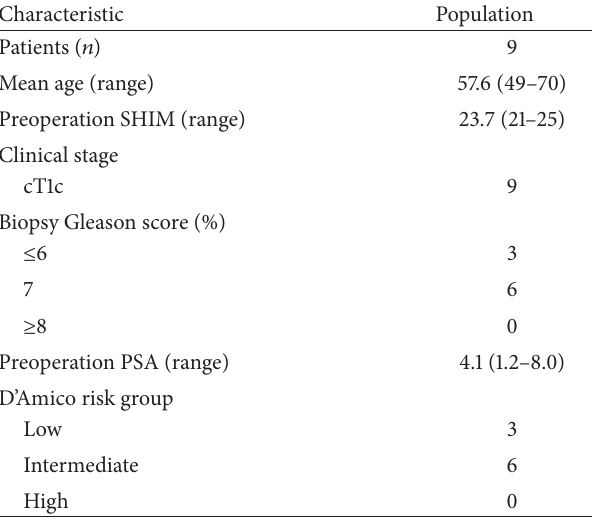
Table 1: Baseline demographic and clinicopathologic characteris- tics.